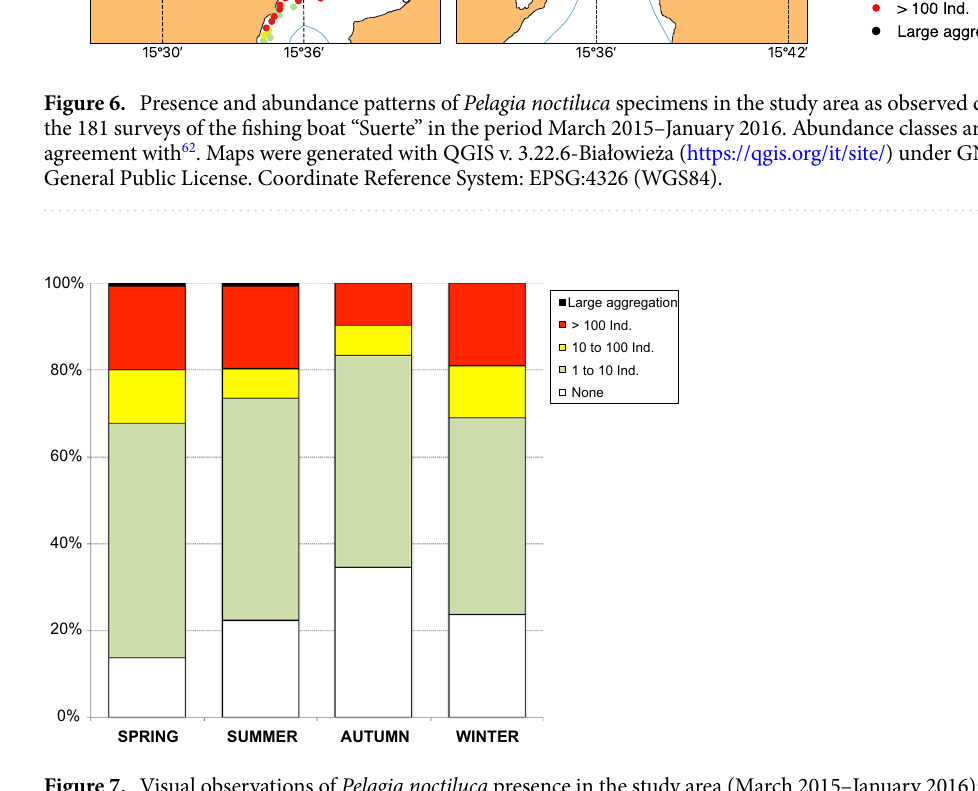
the coast by the flooding ("montante" S–N) current. From 8 to 10 July large quantities of small and medium-sized Pelagia specimens were observed between Pace and Ganzirri (see Fig. 2 for locations) in the ebbing swirls, which disappeared almost entirely with the onset of the tide. Large quantities of Pelagia were also observed on April 7th at the entrance of Messina Harbour during the high tide phase, when the wind was blowing from the NW. Beach strandings. Observations of stranded Pelagia were conducted from March 2015 to February 2016. A total of 3162 specimens were counted, of which 58% along the Sicilian coast (five beaches plus Messina Harbour, see Fig. 2) and 42% along the Calabrian coast (three beaches). On a yearly basis, Faro was the one with the highest number of stranded specimens (28%) among the Sicilian beaches, followed by Ganzirri (22%), S. Francesco (9%), Pace (6%) and S. Raineri (5%). Natural or artificial bays seemed to influence strandings: among the studied beaches, Faro and Ganzirri, where most of the strandings occurred, are the richest in such structures. The high- est number of Pelagia specimens was observed along the docks of Messina Harbour (31%, Fig. 8). Among the